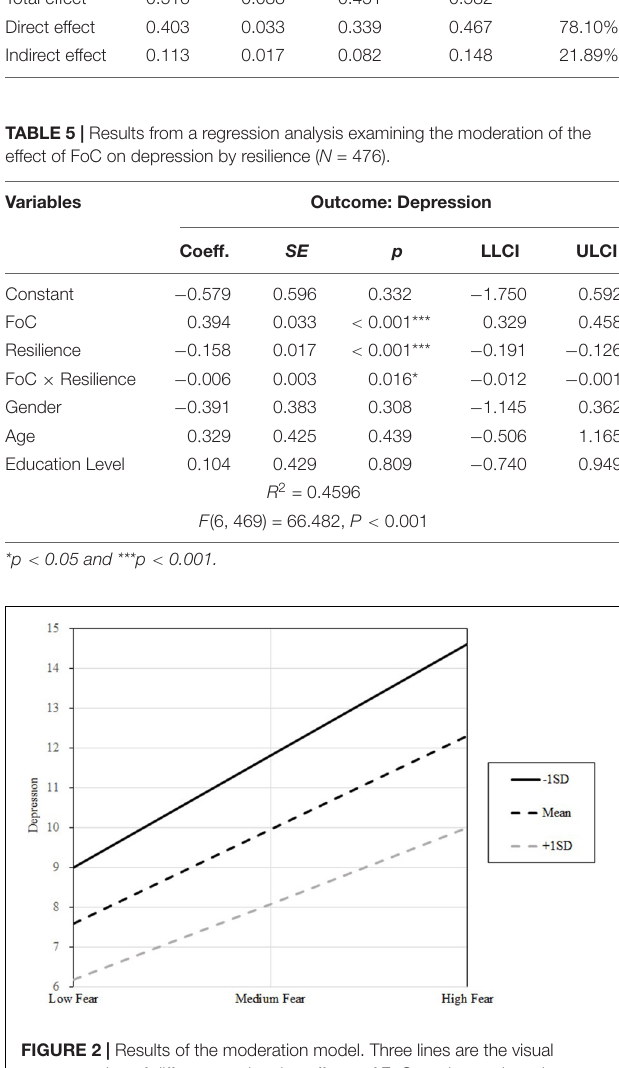
FIGURE 2 | Results of the moderation model. Three lines are the visual representation of different moderation effects of FoC on depression when resilience scores were at its +1 SD, mean, and –1 SD. Fear refers to fear of COVID-19